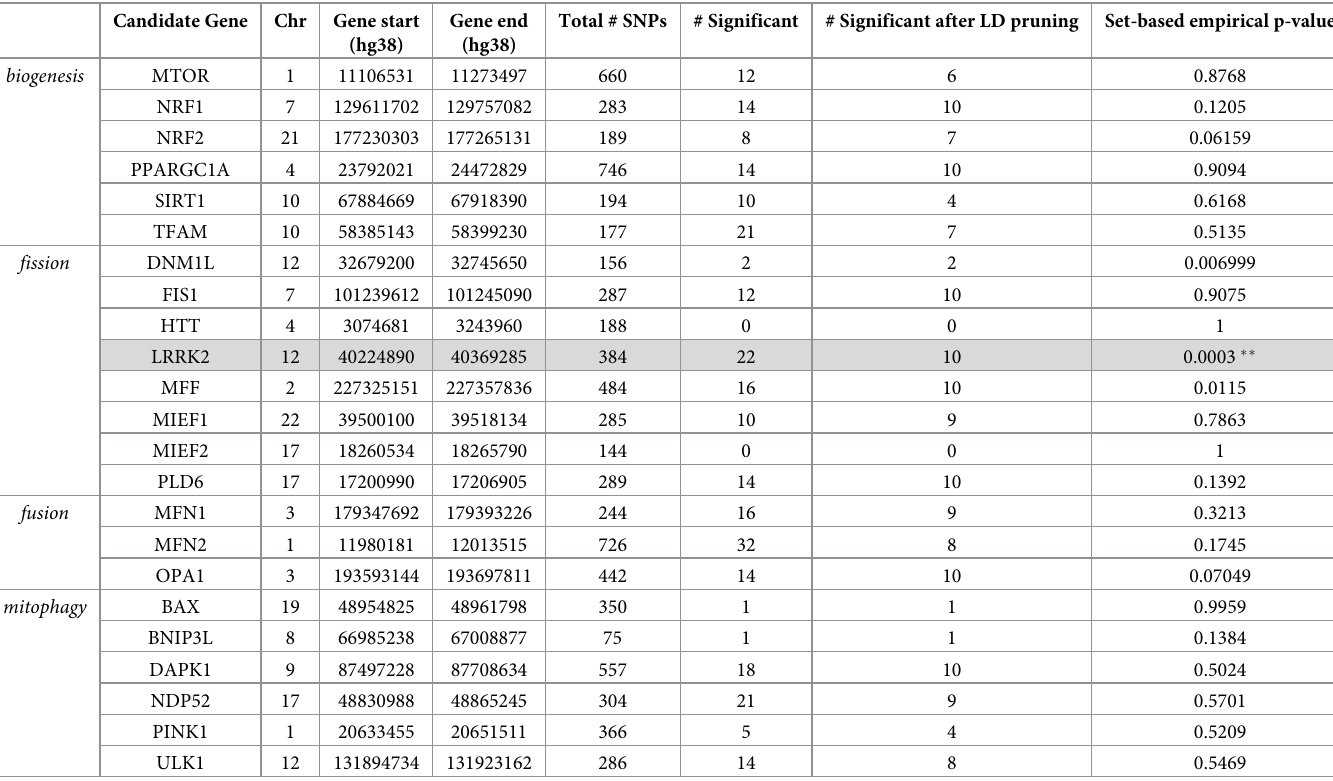
Table 2. Candidate genes and set-based association results with mitochondrial DNA copy number. Candidate